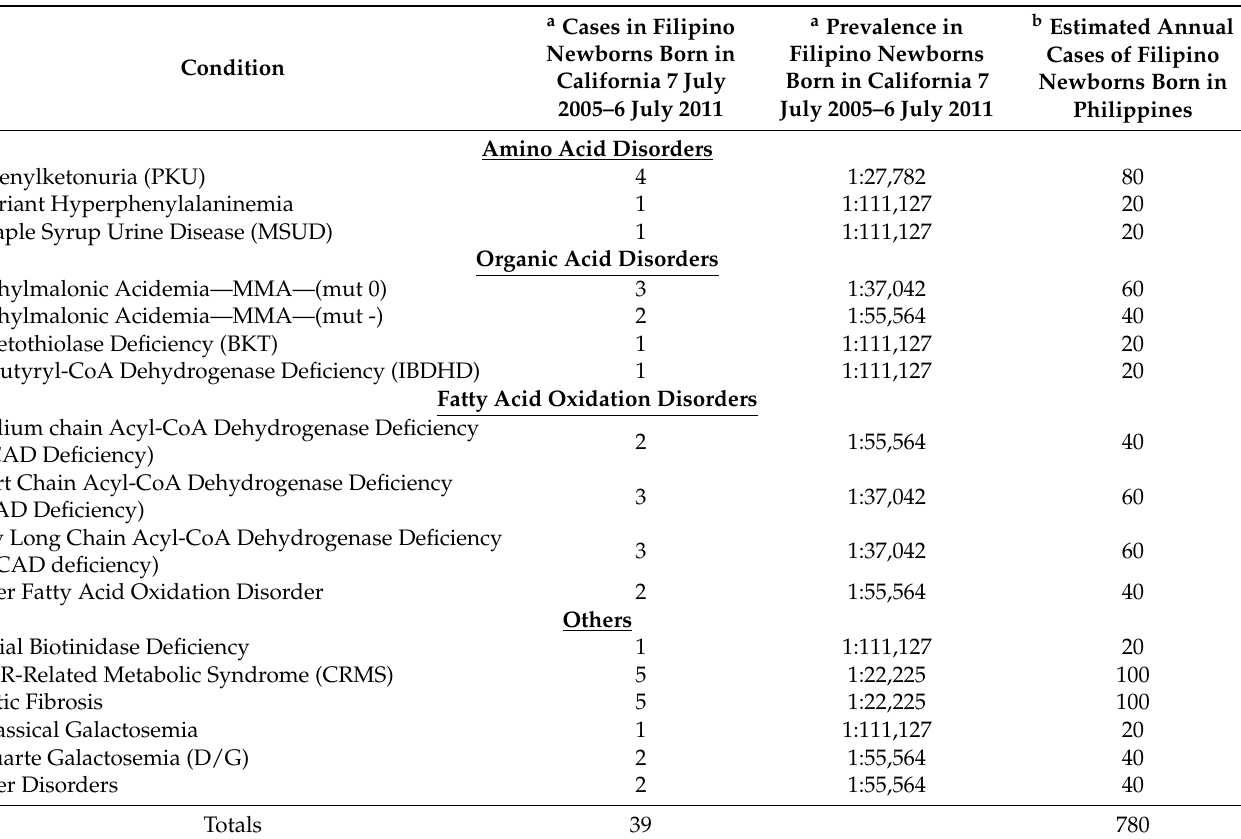
Table 2. Metabolic disorders in Filipino newborns—California vs. Philippines (adapted from Refer- ence